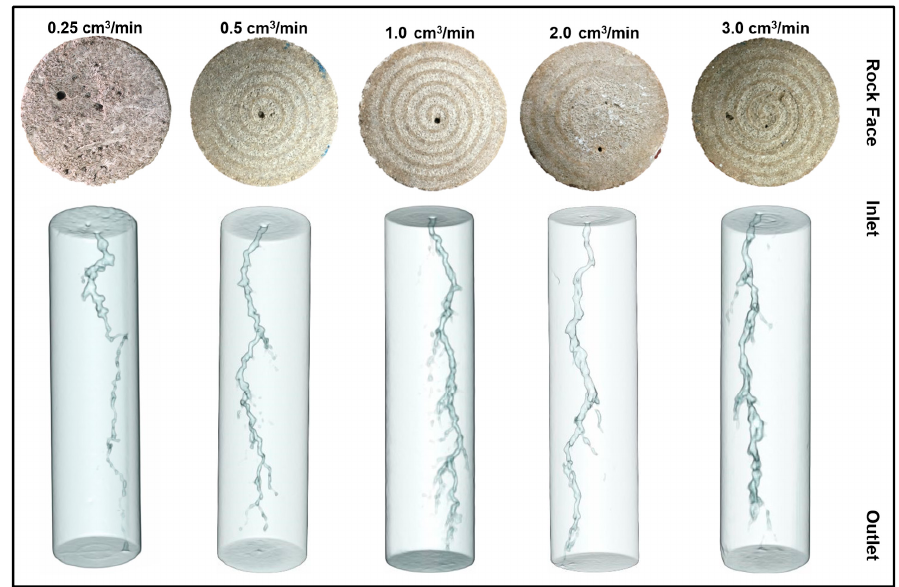
Figure 17. Wormhole structure using CT scan for core samples stimulated using 20 wt% GLDA/SW (pH = 3.8) at 250